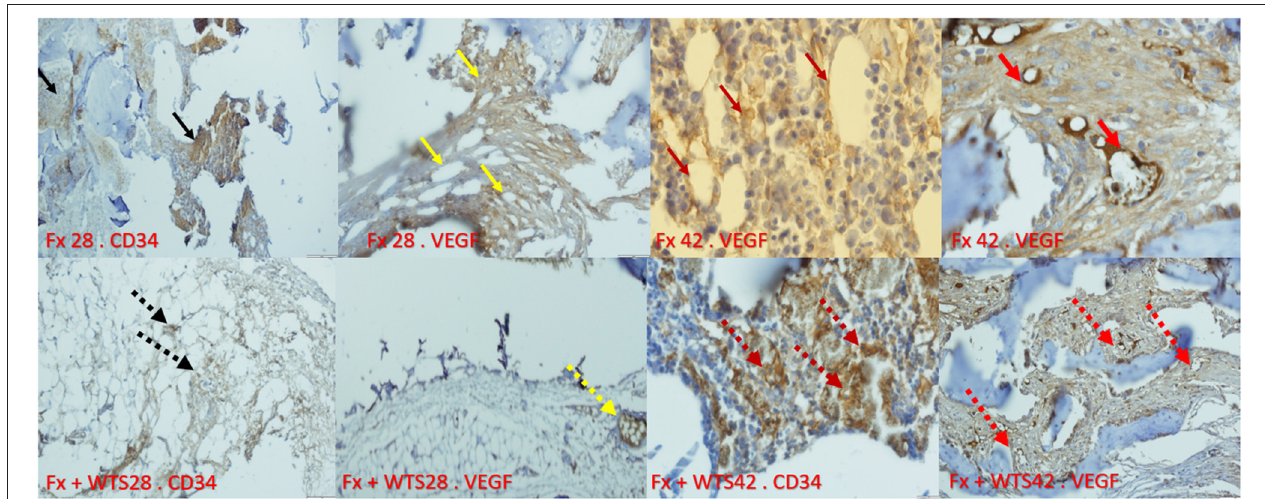
FIGURE 11 | Immunohistochemical representation of the bone fracture area in experimental groups. Fx 28-CD34: The arteries that are properly formed around the fracture tissue (black arrow). Fx 28-vascular endothelial growth factor (VEGF): Represents open arteries and regular vascular tissue and is prominent around the fracture site (yellow arrow). Fx 42-VEGF: Indicates stained osteoblasts and clearly shows VEGF expression in osteoblasts that are active and regular (crimson arrow). Fx 42-VEGF: The vessels inside the callus are actively present and are supplying blood to the repair site (red arrow). Fx + WTS 28-CD34: Small, fragile vessels are shown around the repair site (black arrow point dots). Fx + WTS 28-VEGF: Small vessels and thrombosis are evident at the fracture site (yellow dashed arrow). Fx + WTS 42-CD34: Thrombotic and fragile arteries that are irregular and highly visible at the fracture site (crimson dashed arrow). Fx + WTS 42-VEGF: Small blood vessels inside the fibrotic tissue that are not functioning properly (red dashed arrow). Fx 28: group subjected to room air for 28 days after surgery and a femoral bone fracture, Fx 42: group subjected to room air for 42 days after surgery and a femoral bone fracture, Fx + WTS 28: group subjected to WTS for 28 days after surgery and a femoral bone fracture, Fx + WTS 42: group subjected to WTS for 42 days after surgery and a femoral bone